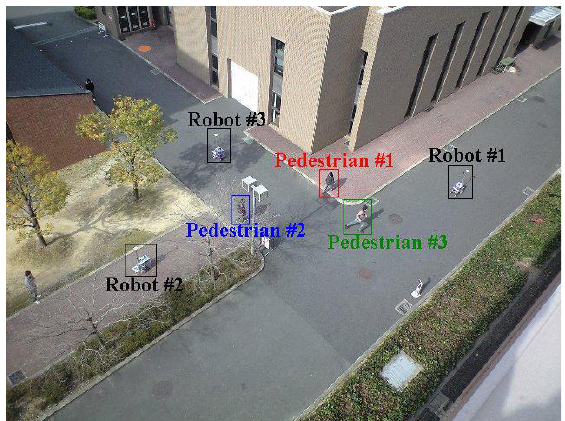
Figure 9. View of experimental environments.